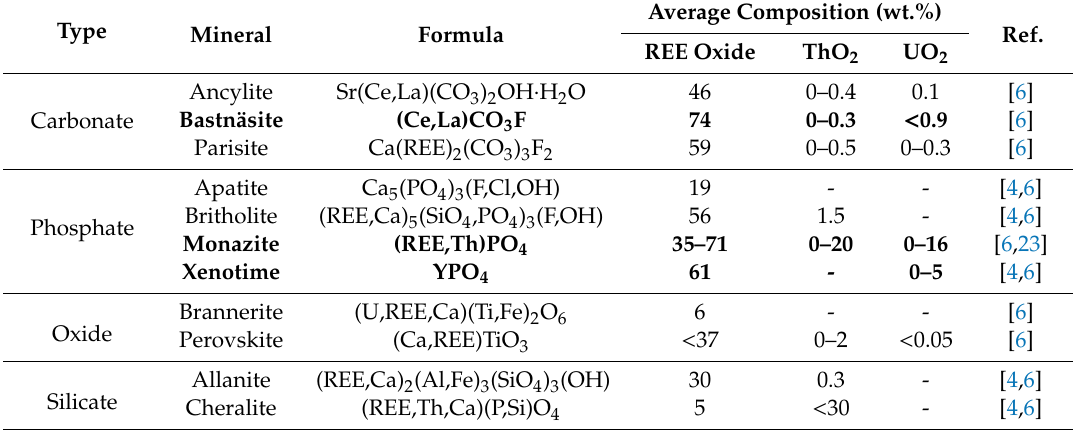
Table 1. REE-bearing minerals and gangue minerals from